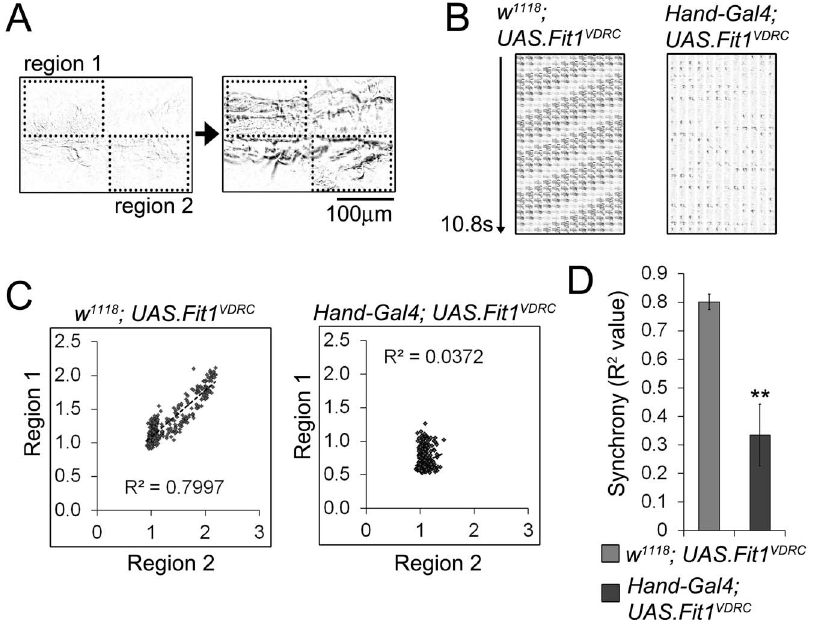
Figure 4. Synchrony between cardiomyocytes is reduced when Fermitin expression is silenced. Videomicroscopy of the contracting heart from control ( w 1118 , UAS.Fit1 VDRC ) or Fermitin -silenced flies ( Hand-Gal4; UAS.Fit1 VDRC ) was analysed for movement to ascertain the degree of synchronicity between the different (depicted) regions of the Drosophila heart. ( A ) Frames from a movement movie of the beating heart where dark pixels indicate movement relative to the previous frame. Pixel intensity in two non-overlapping regions is measured over 10 s and regression analysis performed to quantify the degree of synchrony between the two regions. ( B ) Concatamerised frames from the movement movie were used to develop cardiac actograms which illustrate the regular, synchronous movement of the heart in a control fly ( w 1118 , UAS.Fit1 VDRC ), and asynchronous movements in the heart of a Fermitin silenced fly ( Hand-Gal4; UAS.Fit1 VDRC ). The 360 frames run left to right and top to bottom, the entire sequence being 10.8 s long. ( C ) Representative XY scatter plots of pixel intensity in two regions of a 300 frame, 10 s movement movie, note the lower R 2 value for the Fermitin silenced fly. ( D ) Synchrony (mean R 2 values ( 6 SEM)) for control ( w 1118 , UAS.Fit1 VDRC ) and Fermitin silenced flies ( Hand-Gal4; UAS.Fit1 VDRC ). n =7 flies for each genotype, **P , 0.01.